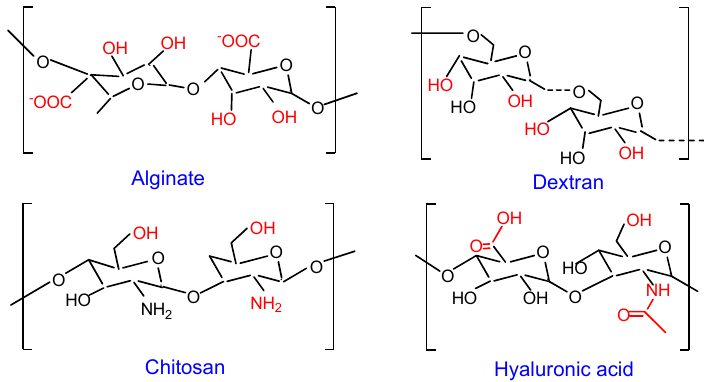
Figure 1. Schematic structure of polysaccharides. Active centre in the repeating unit of each polysaccharide is shown in red font.